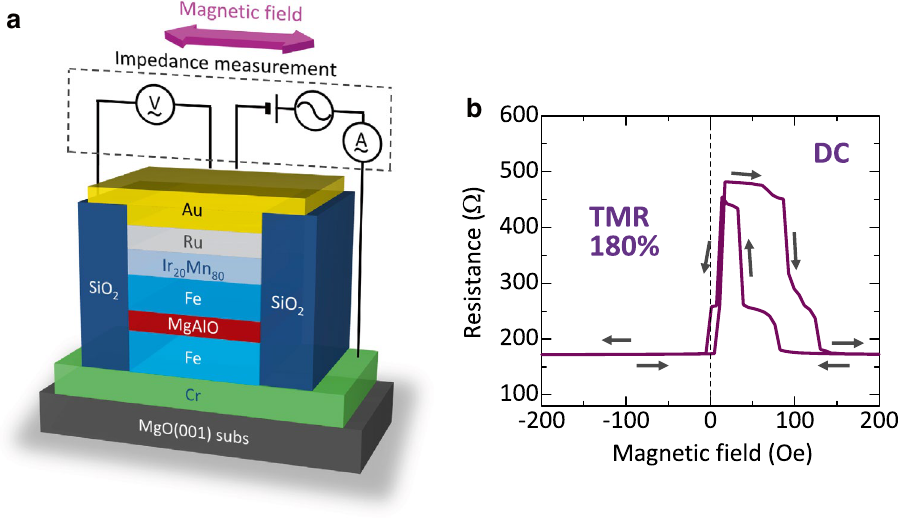
Figure 1. Experimental set-up and device structure. ( a ) Schematic of a patterned MAO-based MTJ with the stack structure. The measurement set-up for TMC is also shown. The magnetic field is applied along the Fe[100]||MAO[110] direction. ( b ) TMR curve measured by a dc four probe